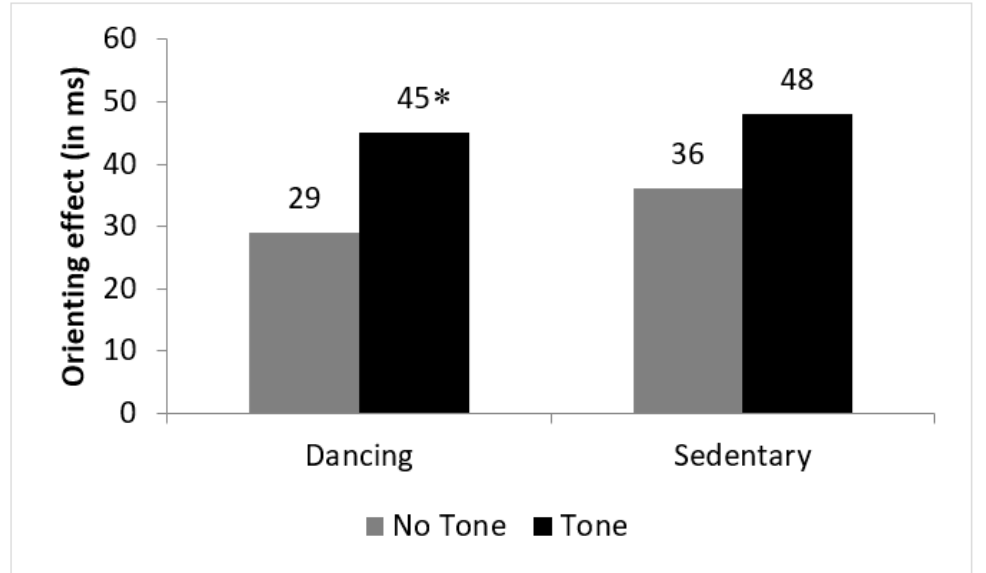
Figure 6. Average orienting effects (invalid RT minus valid RT) for trials with tone and non-tone (numbers over bars) in dancing and sedentary groups. The difference between both tone and non-tone trials was only significant for dancing group (* p < 0.05).